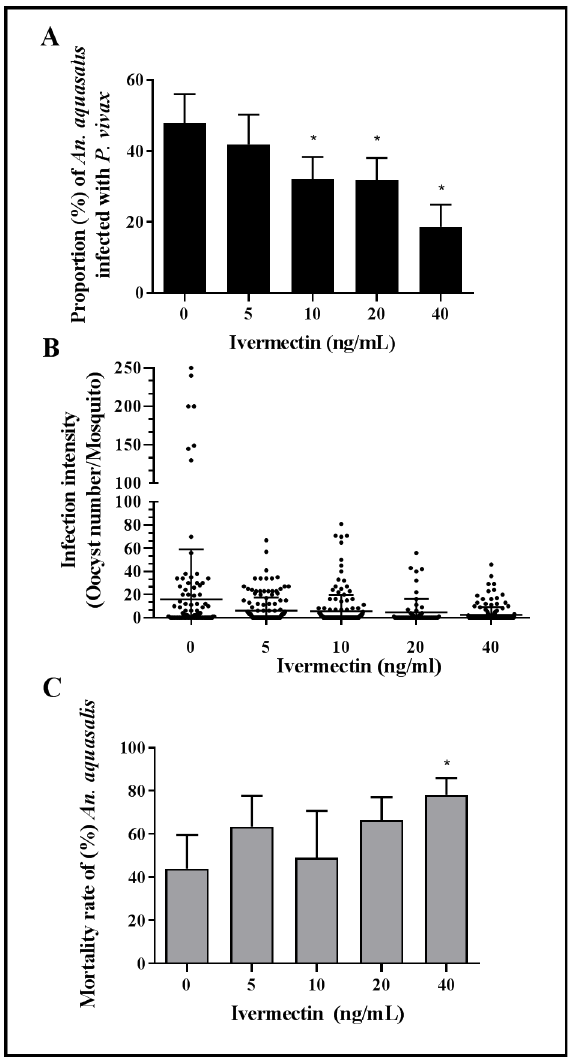
Fig 2. Ivermectin powdered affects Plasmodiumvivax development in Anopheles aquasalis . (A) The proportion of P . vivax infected mosquitoes is presented as a mean and standard deviation. (B) The infection intensity is presented as the number of oocysts per a single midgut (black dots) and the black lines represent the mean and standard deviation. (C) Mosquito mortality rate to 7 days post-feeding is presented as mean and standard deviation. Data from 5 independent experiments are presented in A-C. Asterisks ( (cid:3) ) represent significant difference (P < 0.05) in relation to the